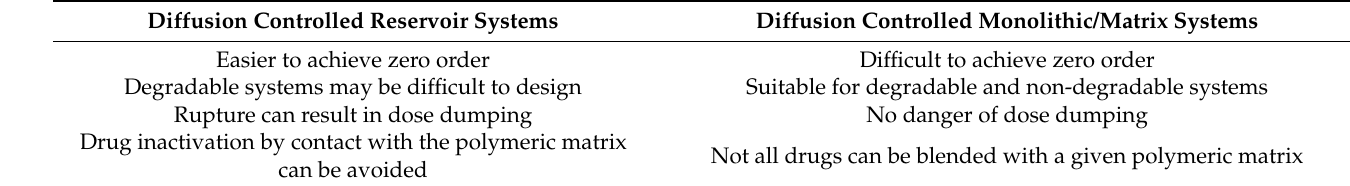
Figure 26. Monolithic/matrix-controlled drug delivery systems. Table 5. Diffusion-controlled reservoir and matrix